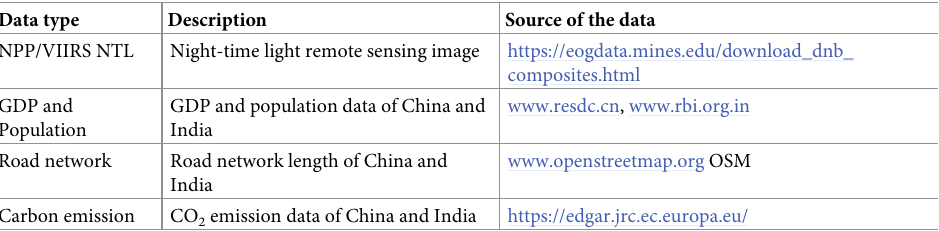
Table 1. Introduction to